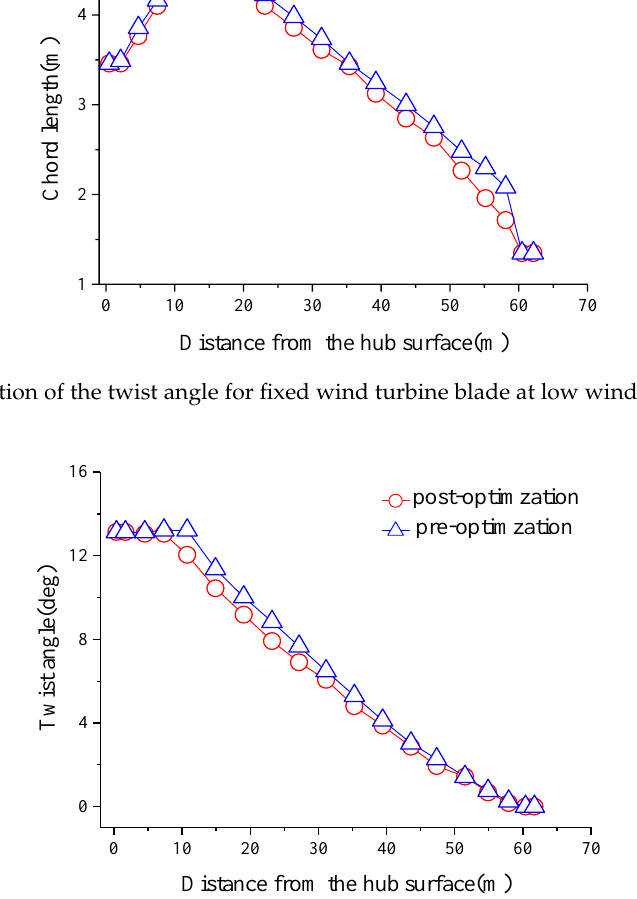
Figure 8. Distribution of the twist angle for fixed wind turbine blade at low wind speed before and after optimization.